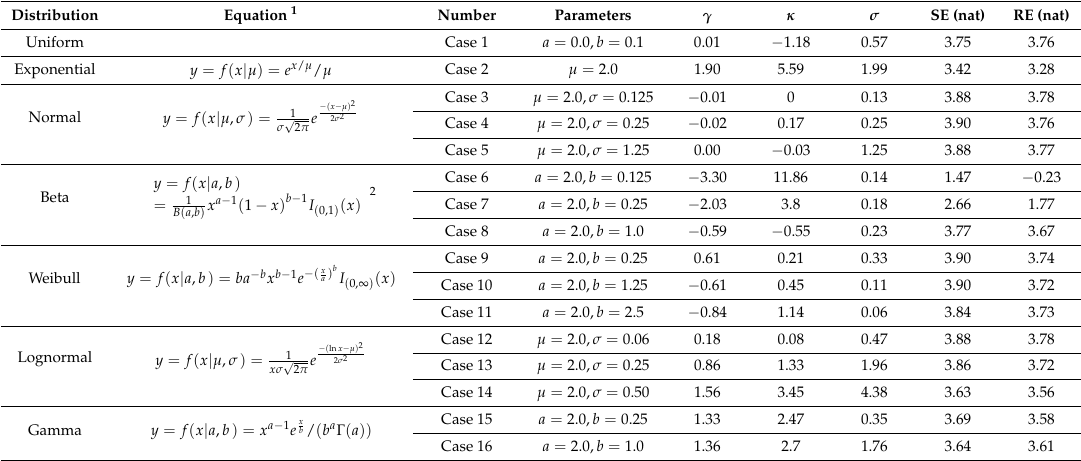
Table 2. The distribution parameters of seven typical distributions and their